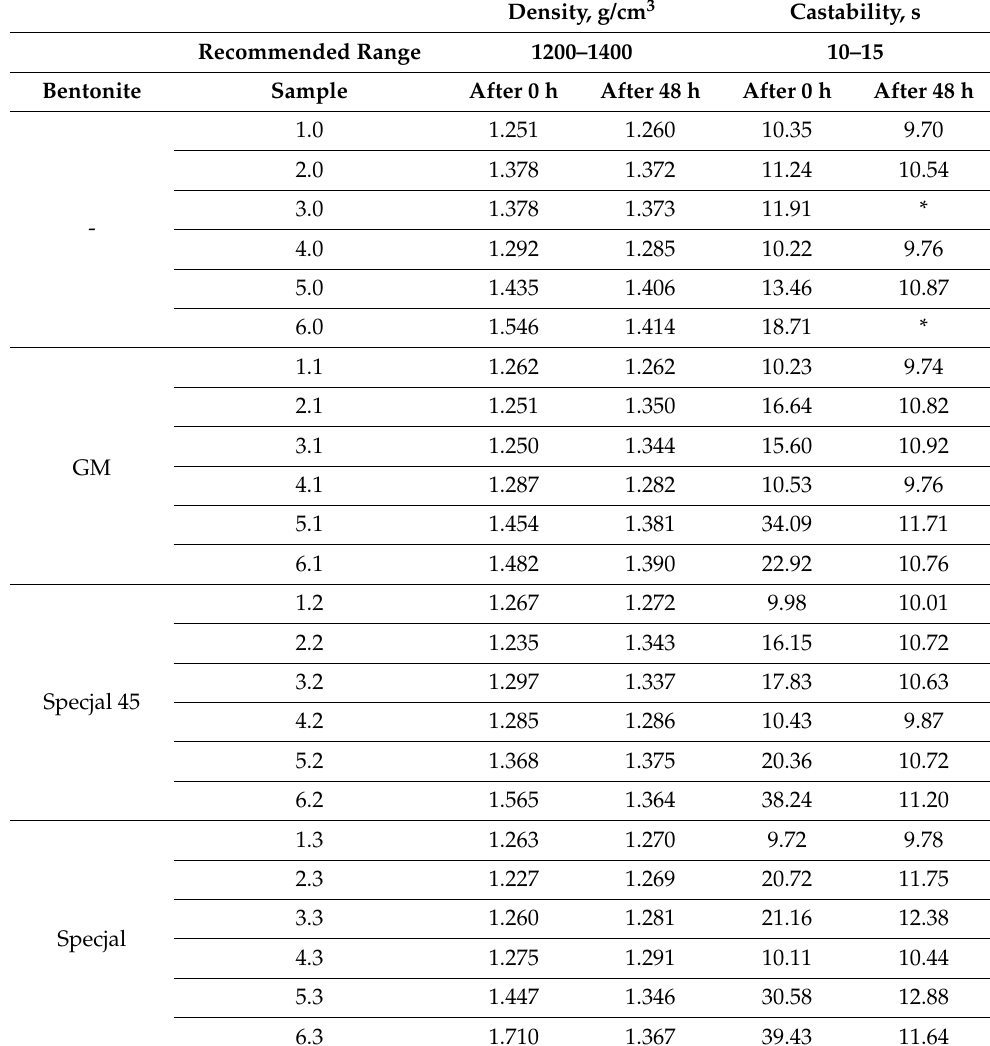
Table 9. Physical parameters of the produced samples of suspension fertilizers.